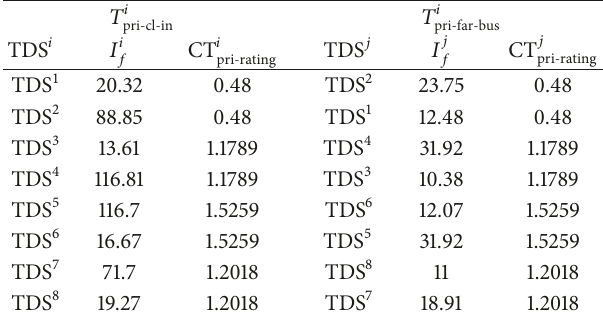
Table 8: Values of constants for objective function of 4-bus